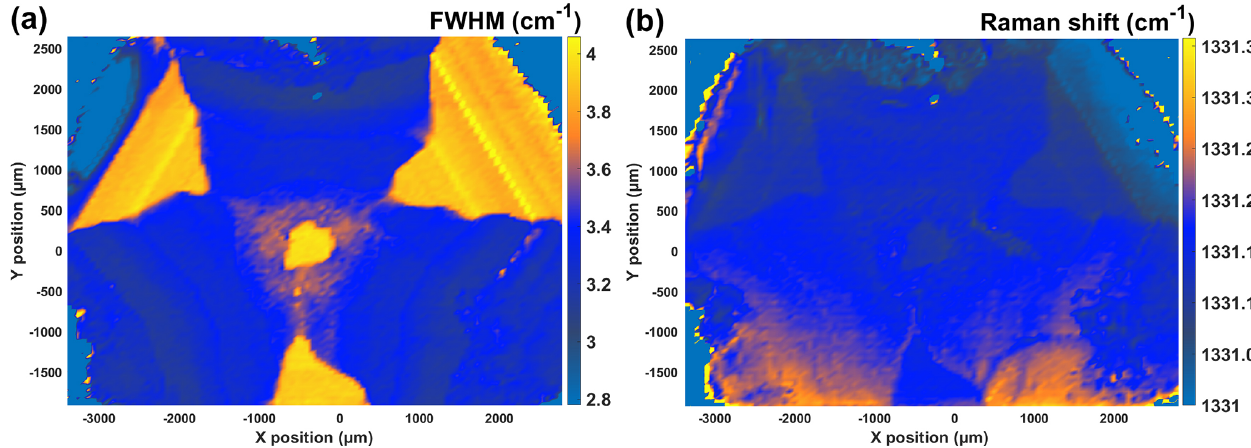
Figure 5. The maps of the (a) FWHM and (b) Raman shift of diamond LO = TO bands in NDS-2.